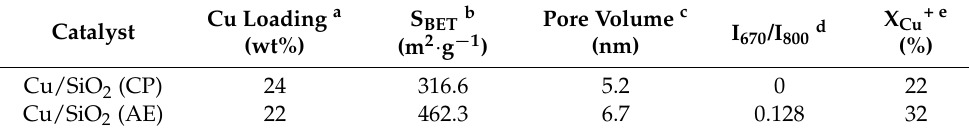
Table 1. Physical and chemical property of Cu/SiO 2 (CP) and Cu/SiO 2 (AE) catalysts.